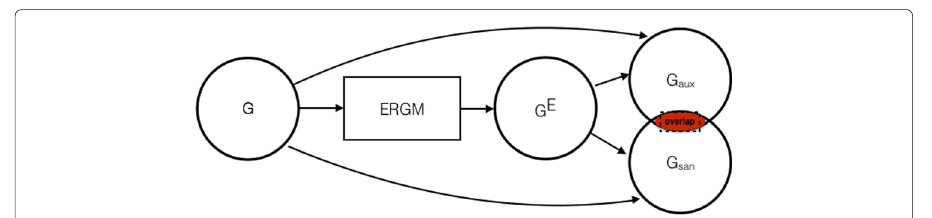
Fig. 1 Graph mining system flow to generate node pairs with the ground truth of identical and non-identical